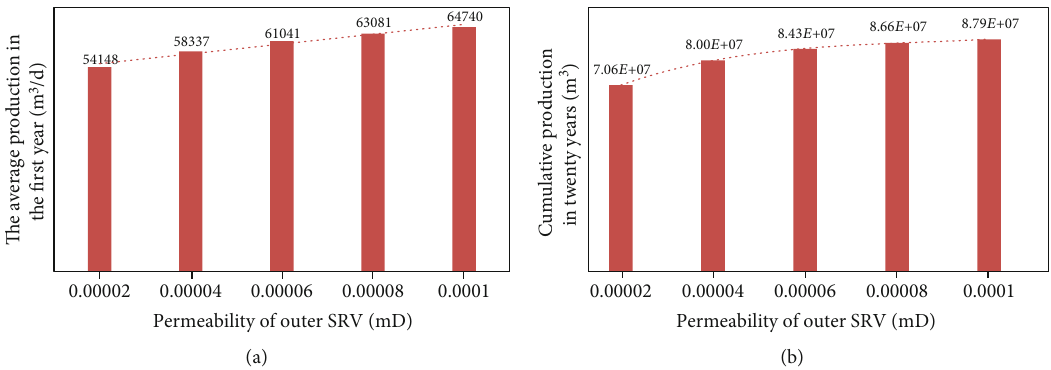
Figure 7: E ff ects of the permeability of outer SRV on gas production rate (a) and cumulative production